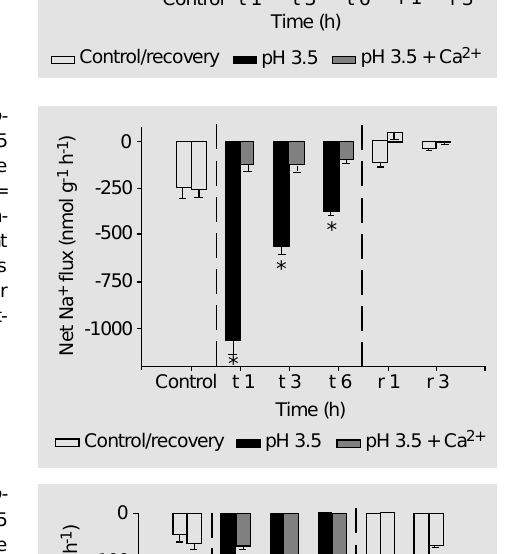
Figure 1. Net Na + flux of Corydo- ras adolfoi exposed to pH 3.5 and pH 3.5 plus Ca 2+ . Values are reported as means ± SEM (N = 10). *P (cid:1) 0.05 compared (cid:0) to a con- trol measurement performed at pH 6.0 (Dunnett test). Water was changed to circumneutral pH for recovery (r) after 6 h of treat- ment (t).